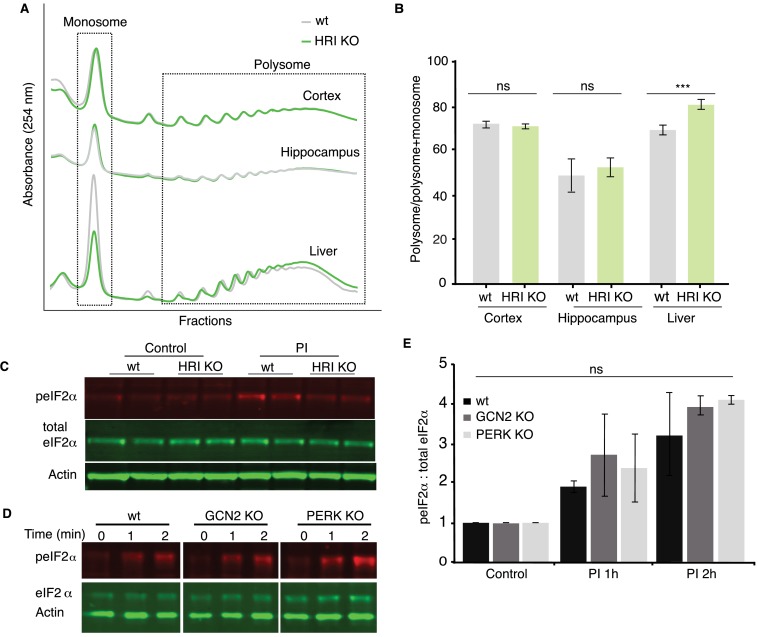
Polysome and eIF2α phosphorylation data from eIF2α kinase knock-outs.(A) Representative polysome profiles from WT or HRI KO cortex, hippocampus or liver. (B) Quantification of the experiment shown in A and additional similar experiments. Shown is the fraction of profiling signal detected in the polysome fraction, expressed as a ratio of polysome: polysome + monosome. The absence of HRI (HRI KO) did not change the fraction of signal detected in the polysome in either cortex or hippocampus but did reduce the polysome signal (and enhanced the monosome signal) in liver. WT vs. HRI KO in cortex and hippocampus p>0.05, both not significant, WT vs. HRI KO in liver p≤0.001, n = 6 technical replicates and three biological replicates for all samples. All analyses used unpaired t-tests. Error bars = SEM. (C) Representative western blot showing the levels of peIF2α and total eIF2α following proteasome inhibition in cortical cultures prepared from WT or HRI KO mice. (D) Western blot analysis of eIF2α phosphorylation and total levels following 1 or 2 hr of proteasome inhibition (MG132, 10 μM) in WT, GCN2 KO or PERK KO cultured neurons. Actin is shown as a loading control. (E) Analysis of experiment in D and additional similar experiments. The PI-dependent increase in peIF2α was not significantly altered in either the GCN KO or the PERK KO. WT vs. GCN2 KO at 1 (n = 2) and 2 hr (n = 2) of PI treatment: p>0.05 and p>0.05, not significant. WT vs. PERK KO at 1 (n = 2) and 2 hr (n = 2) of PI treatment: p>0.05 and p>0.05, not significant. All unpaired t-tests, error bars = SD.Figure 3—figure supplement 1—source data 1.Source data for Figure 3—figure supplement 1B,E.Figure 3—figure supplement 1—source data 2.Source data for Figure 3—figure supplement 1C,E.